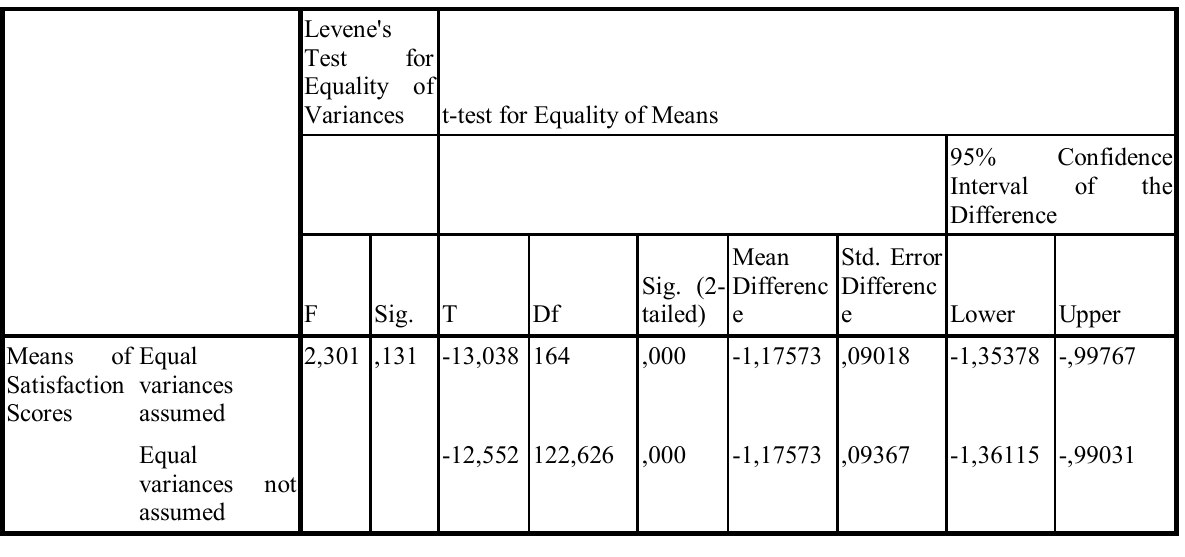
Table.4. Independent Samples T Test’s Results